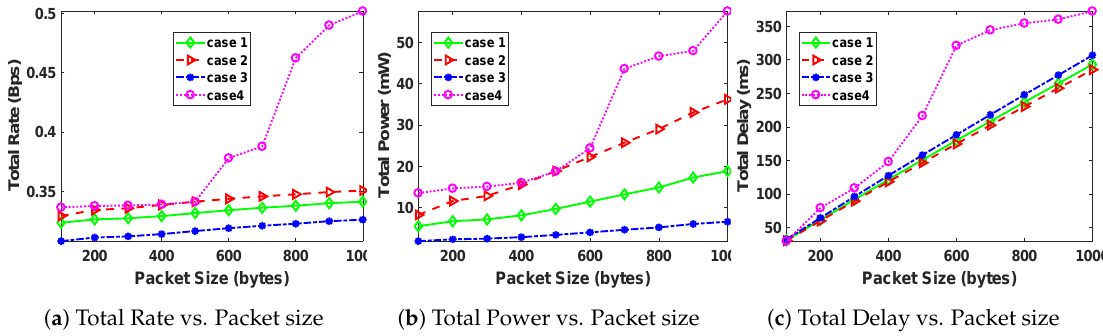
Figure 3. Effect of packet size on the optimal rate, power and